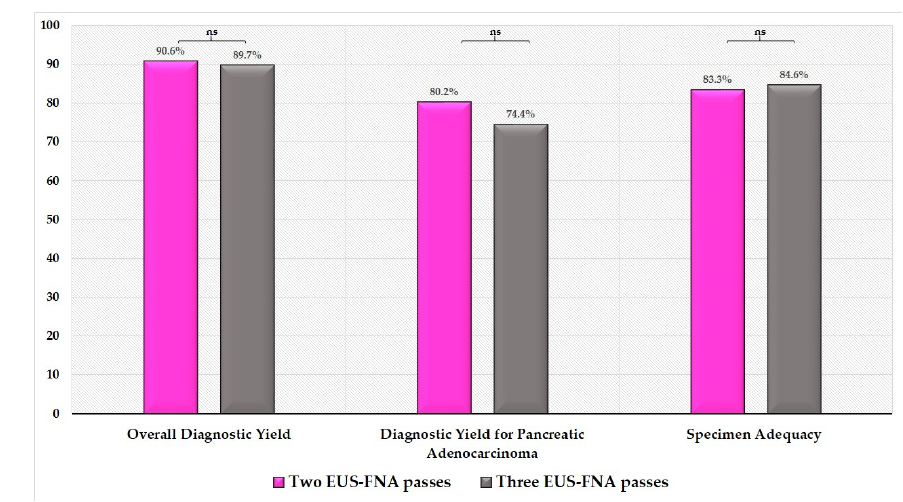
Figure 3. Overall diagnostic yield, diagnostic yield for pancreatic adenocarcinoma and specimen adequacy for 2 and 3 EUS-FNA passes (ns = not significant).